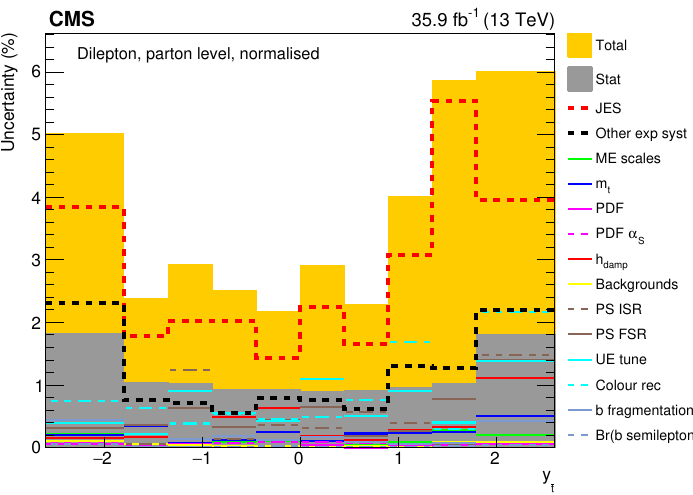
Figure 17 . The contributions of each source of systematic uncertainty to the total systematic uncertainty in each bin is shown for the measurement of the normalised tt production cross sections as a function of y . The sources a(cid:11)ecting the JES are added in quadrature and shown as a single t component. Additional experimental systematic uncertainties are also added in quadrature and shown as a single component. Contributions from theoretical uncertainties are shown